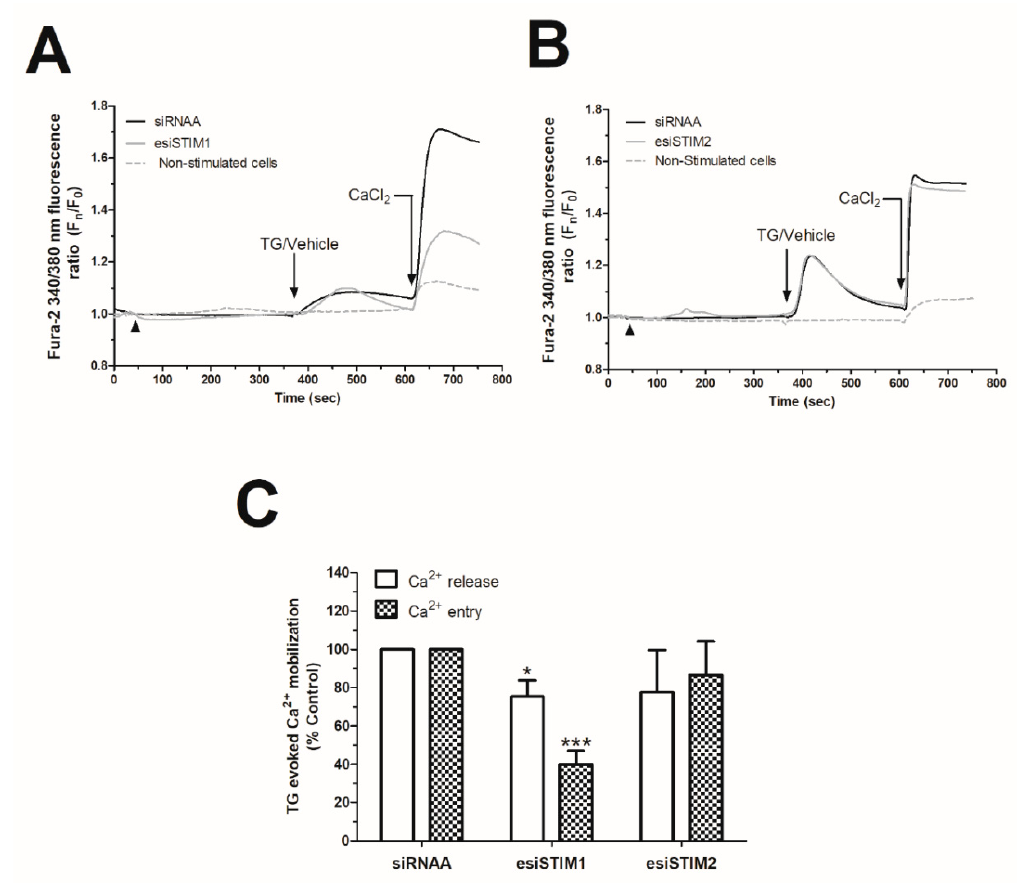
Figure 5. E ff ect of stromal interaction molecule 1 (STIM1) and STIM2 silencing on thapsigargin (TG)-evoked store-operated Ca 2 + entry (SOCE) in MDA-MB-231 cells. MDA-MB-231 cells were transfected with either endonuclease-generated siRNA against STIM1 (esiSTIM1) ( A ) and esiSTIM2 ( B ) or siRNA ( A , B ). Ca 2 + experiments under single-cell imaging configuration were performed by loading cells with fura-2 / AM. Fura-2-loaded cells were maintained in a Ca 2 + -free HBS medium (75 µ M of ethylene glycol-bis( β -aminoethyl ether)- N , N , N (cid:48) , N (cid:48) -tetraacetic acid (EGTA) was added, arrowheads) and were stimulated with 2 µ M of TG or treated with the vehicle for 4 min, while we monitored the TG-evoked Ca 2 + release. Subsequently, TG-evoked Ca 2 + entry (SOCE) and constitutive Ca 2 + entry were visualized by adding CaCl 2 (1 mM) to the extracellular medium and were monitored for an additional 2 min. Graphs are representative of 6–8 independent transfections. ( C ) The histogram represents the average of the percentage ± Standar Erro of the Mean S.E.M., resulting in the analysis of the areas under the curves evoked by TG in around 60–80 cells from 6–8 independent transfections. *, ***: represent p < 0.05 and p < 0.001 with respect to the Ca 2 + mobilization values found in scrambled MDA-MB-231 cells.